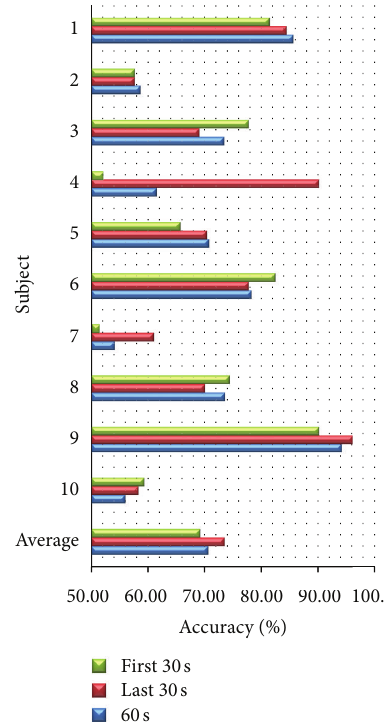
Figure 9: Accuracy from different time